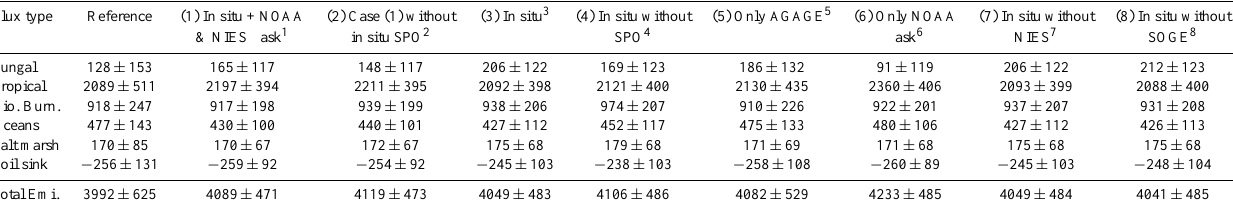
Table 3. Reference and optimally estimated five-year averaged surface fluxes and their errors for aseasonal and seasonal processes (Ggyr − 1 ) obtained by using different combinations of data from the sampling networks. Total emissions are the sum of the estimated sources, the constant industrial source, and the annual average wetland emissions (with soil sink excluded).